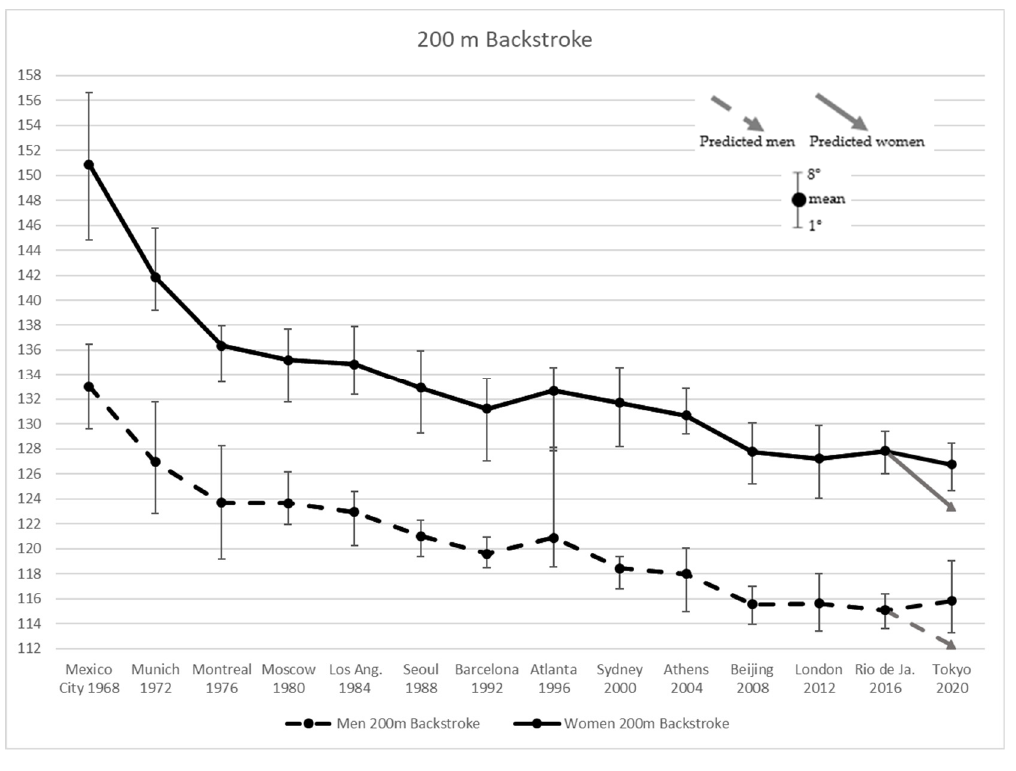
Figure 4. Men’s and Women’s 200 m Backstroke results from Mexico City 1968 to Tokyo 2020 Olympic Games, and the values predicted for the latter.